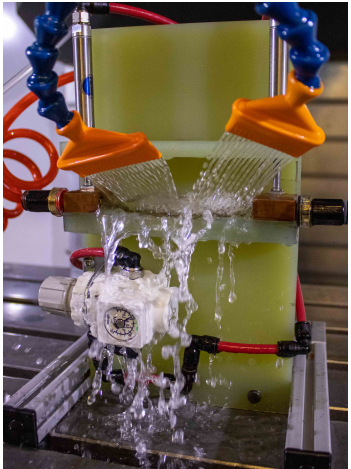
Figure 11. Water-cooling, water-quench test